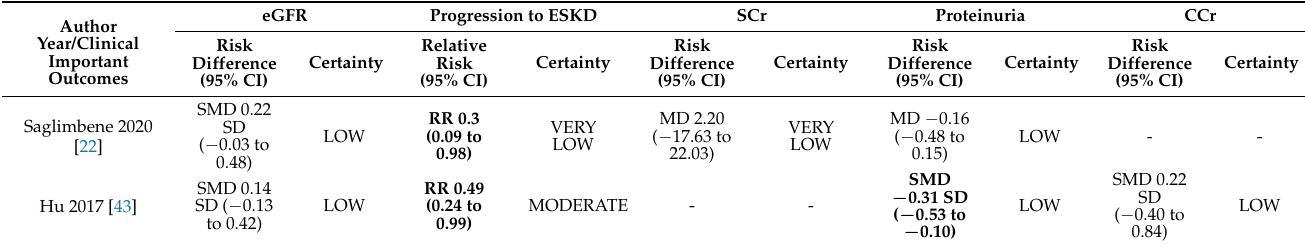
Table 5. Summary of clinical important outcomes and certainties on the renal protection effect of Omega-3 polyunsaturated fatty acid compared to placebo.